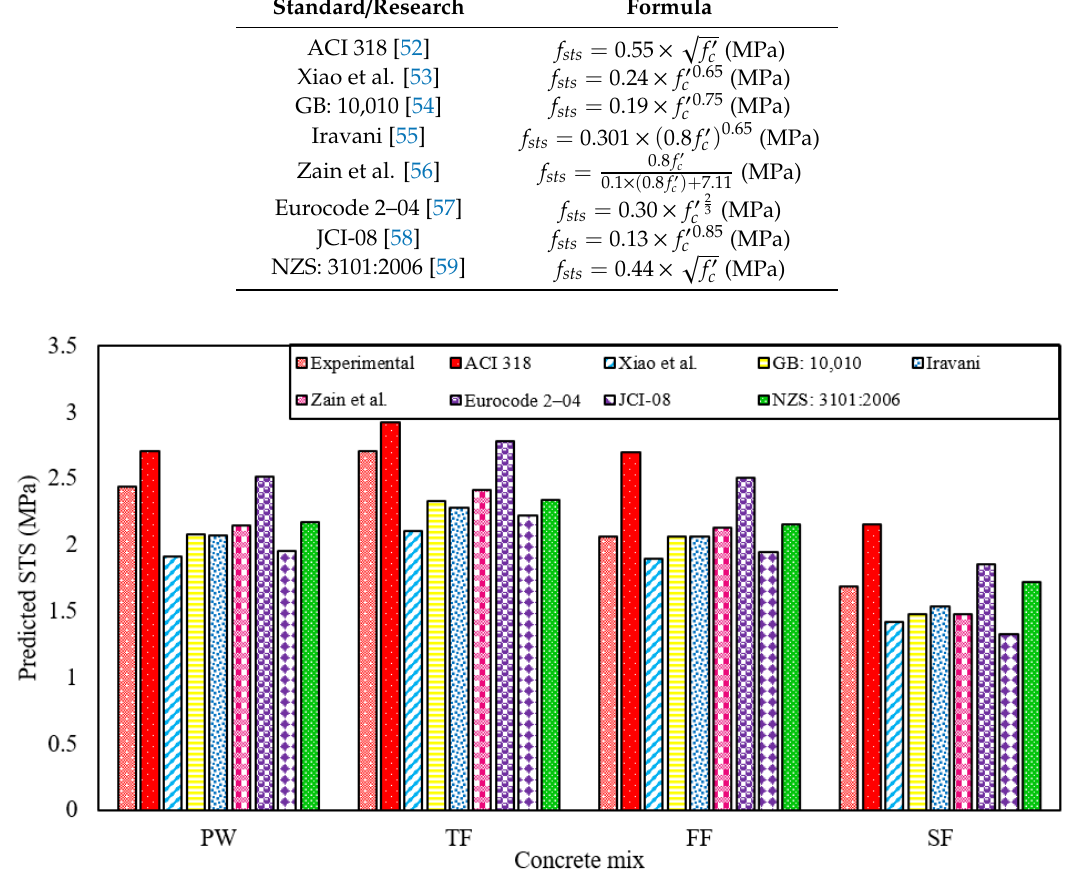
Figure 7. Comparison of predictions of various equations for the STS for RAGC mixes.